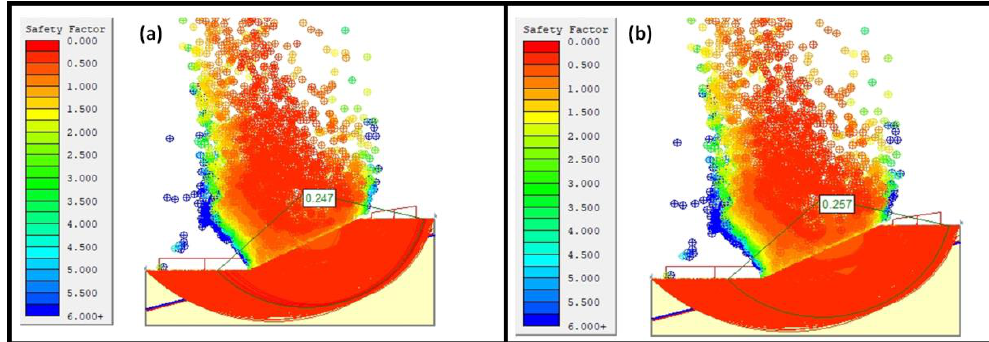
Figure 27. Safety factor simulated for drained to undrained conditions in clay loam soil slope using ( a ) Bishop’s simplified method and ( b ) Janbu’s simplified method.